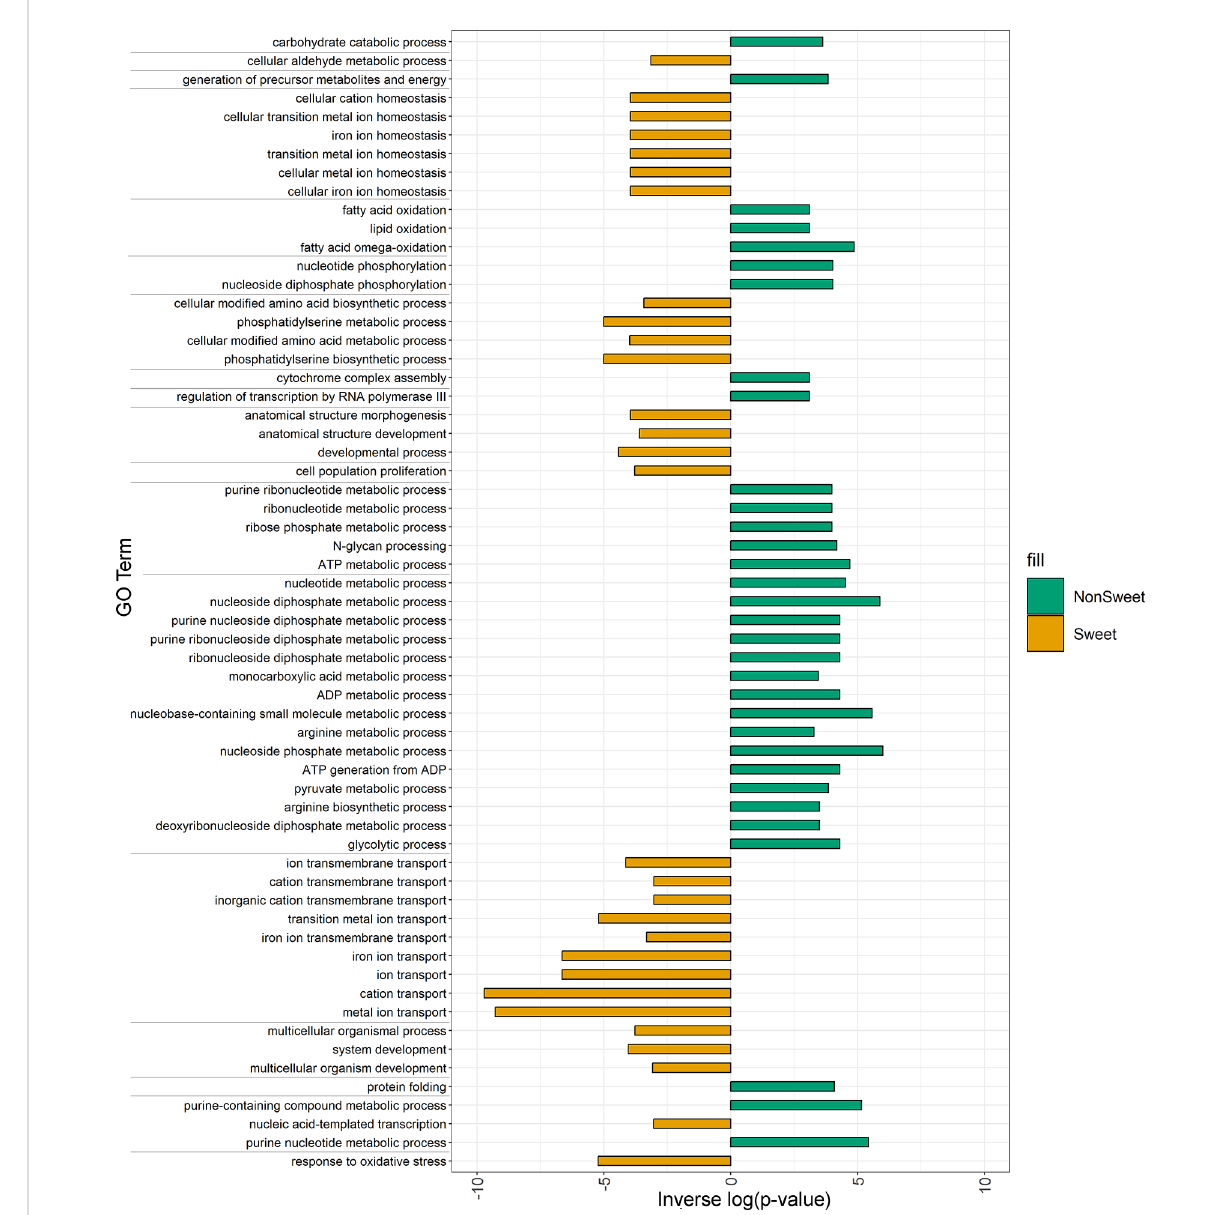
FIGURE 6 Enriched GO terms for genes impacted by SVs and Indels in both Non-Sweet and Sweet Genotypes. Orange bars indicated gene categories in sweet genotypes that were signi fi cantly impacted (p<0.05). Green bars indicated gene categories in non-Sweet genotypes that were signi fi cantly impacted (p<0.05). The length of each bar corresponds to signi fi cance (-log(p-value)). Terms have been clustered and sorted based on semantic